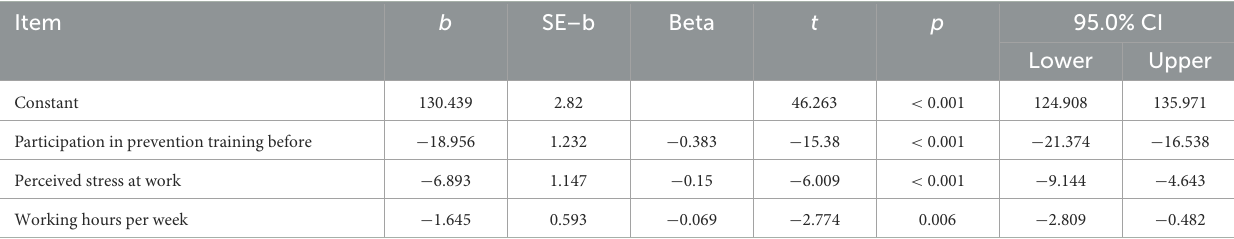
TABLE 4 Multiple linear stepwise regression analysis for influencing factors of nurses’ occupational low back pain prevention capability.